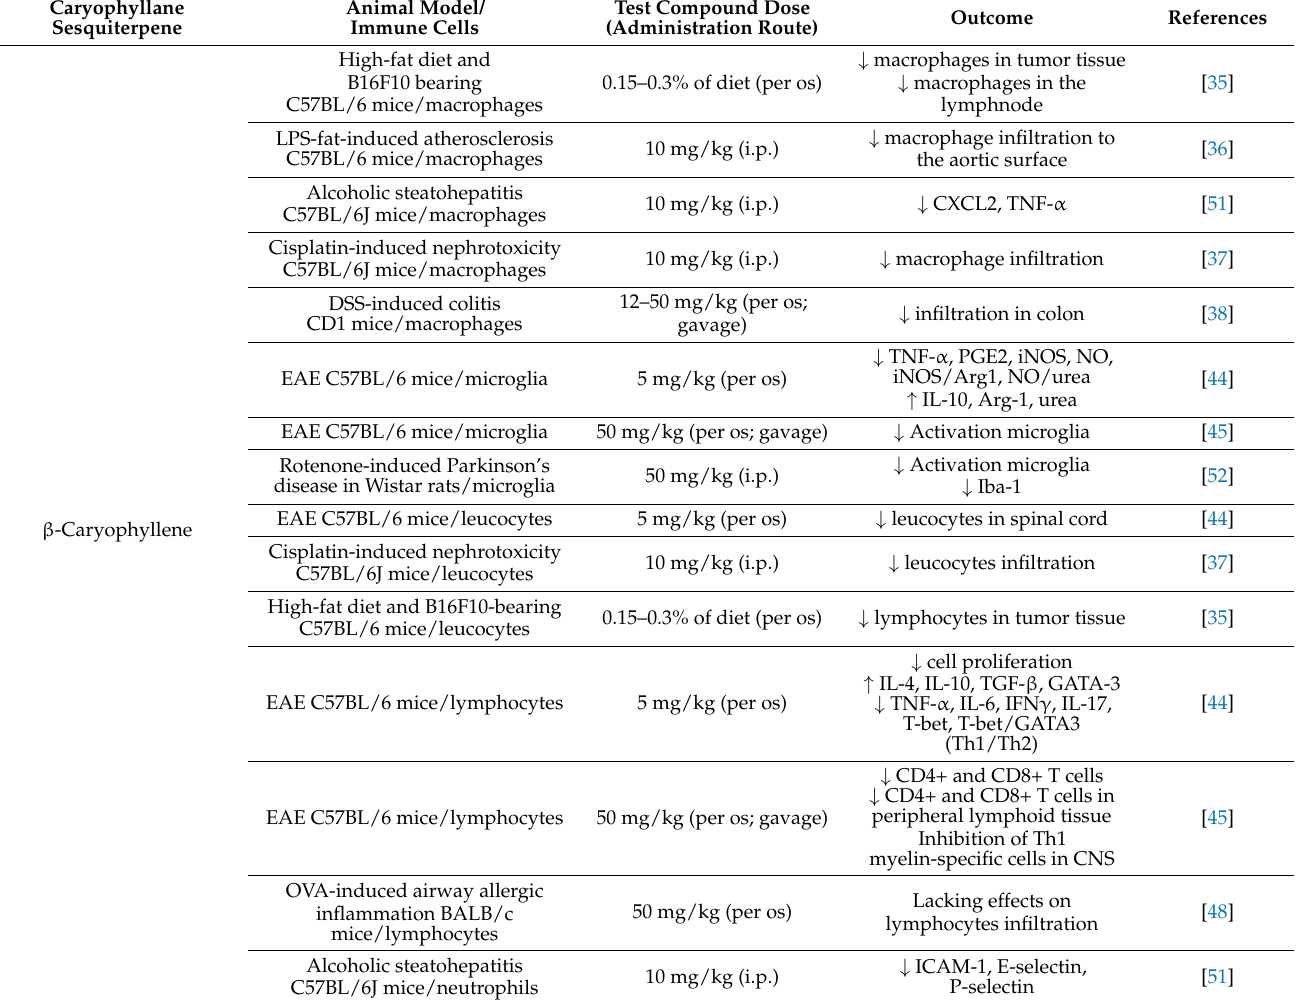
Table 2. Immunomodulatory effects of caryophyllane sesquiterpenes in animal models of disease. Caryophyllane